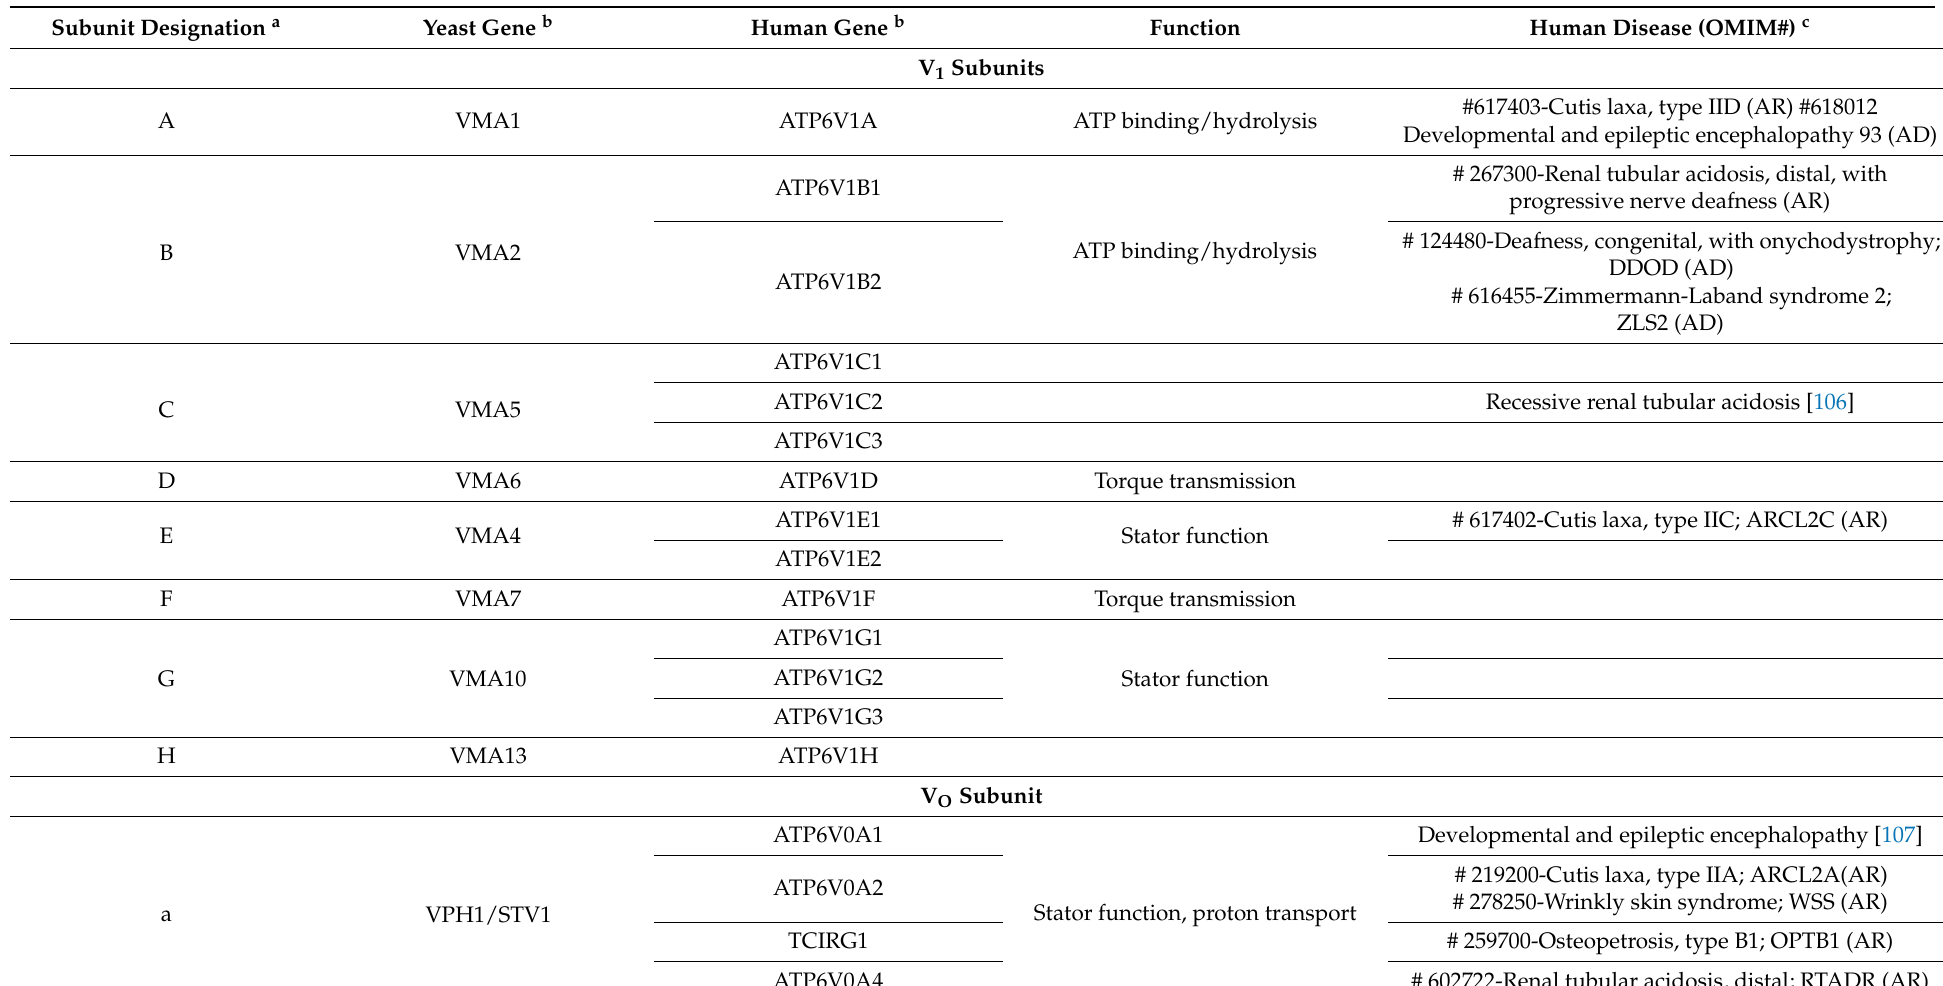
Table 1. Summary of V-ATPase subunit nomenclature, gene designation and associated human